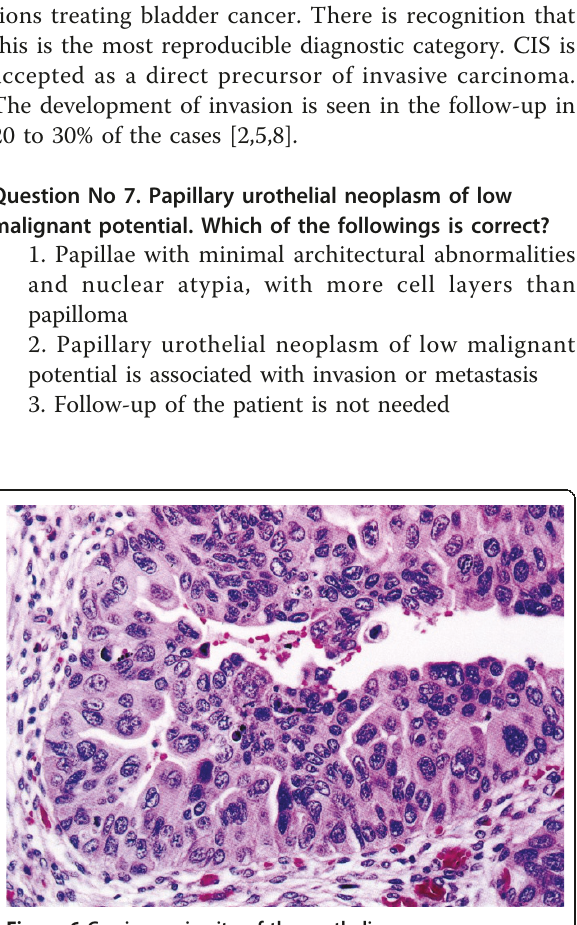
Figure 6 Carcinoma in situ of the urothelium .